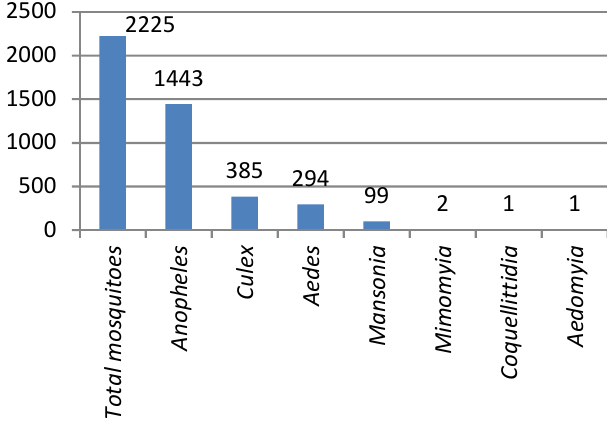
Figure 3. Mosquito numbers by genera: total adults collected October 2017–October 2018.